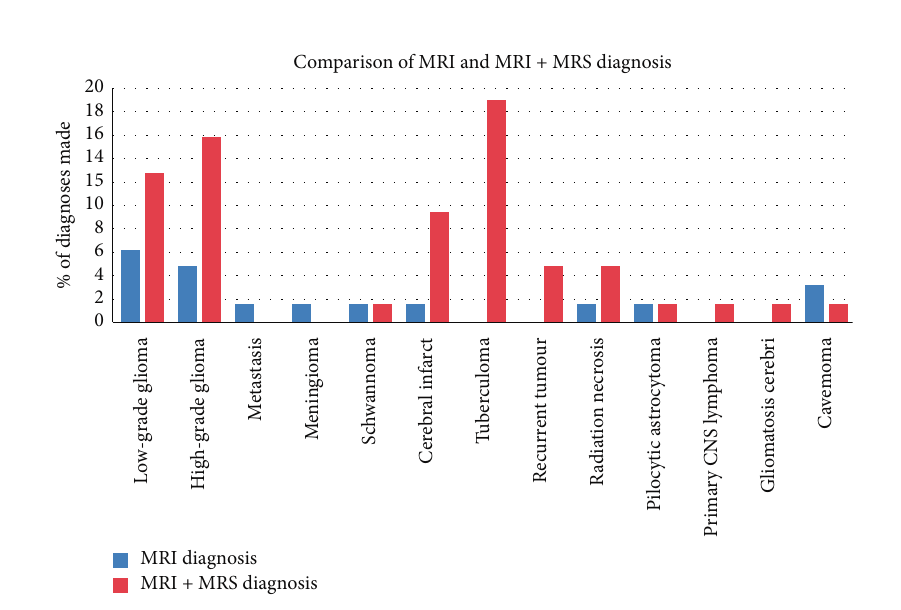
Figure 3: Comparison of MRI and MRI +MRS